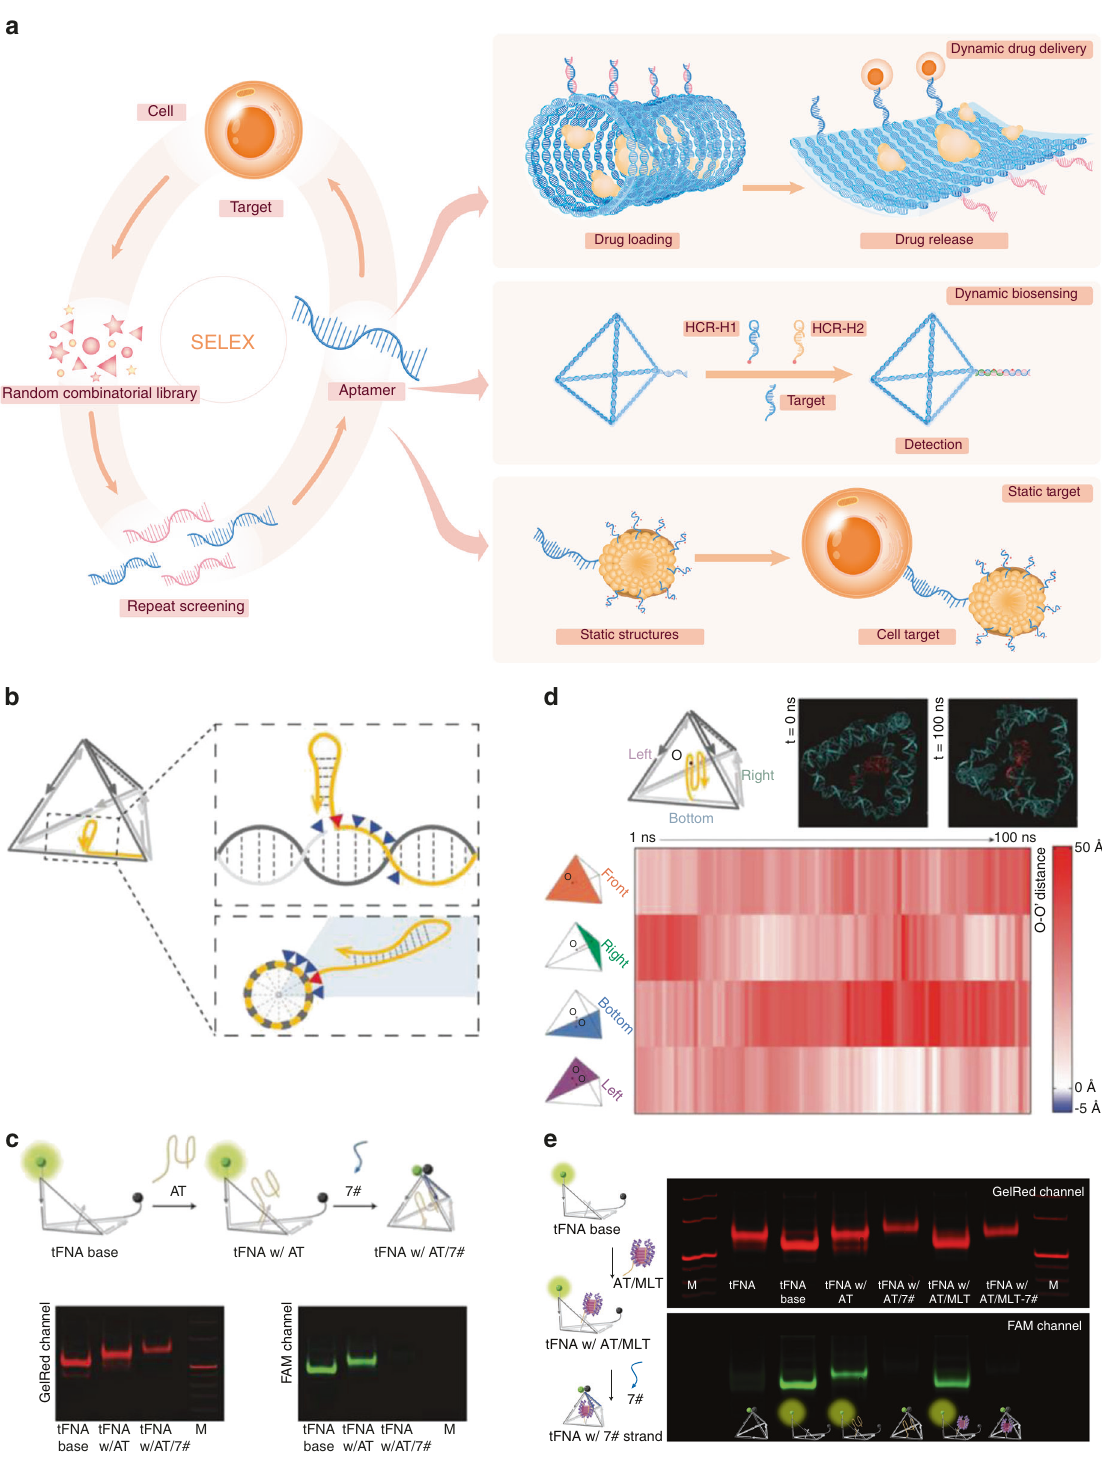
Fig. 1 Dynamic DNA structures based on DNA aptamers. a Schematic illustration of the screening process for aptamer and aptamer-based nucleic acid nanostructures. b Continuous sites were screened for cargo loading via PAGE (screened sites are denoted as blue triangles). The best loading site (shown in the panel, red triangle) was selected by lagging tag modi fi cation (yellow loop at the 3 ′ end). c The cargo loading strand (attachment strand, AT strand) was loaded into the exoskeleton with stepped annealing: the green sphere represents the 3 ′ modi fi cation of FAM, the black sphere represents the 5 ′ modi fi cation of BHQ-1. The fl uorescence changes and band shifts in the PAGE gel indicated successful fabrication of the AT strand-loaded tFNA exoskeleton. d All-atom MD simulation of the AT strand-loaded tFNA exoskeleton revealed that the AT strand was well encapsulated inside the tFNA exoskeleton. The distances between the center of mass of the G-quadruplex strand (O) and the four surfaces of the tFNA (O-O ′ ) were calculated to be positive in the equilibrium state. e The MLT-loaded tFNA exoskeleton, the nanobee, was fabricated via three-step annealing and veri fi ed by PAGE gel electrophoresis. 113 Copyright 2022, John Wiley and